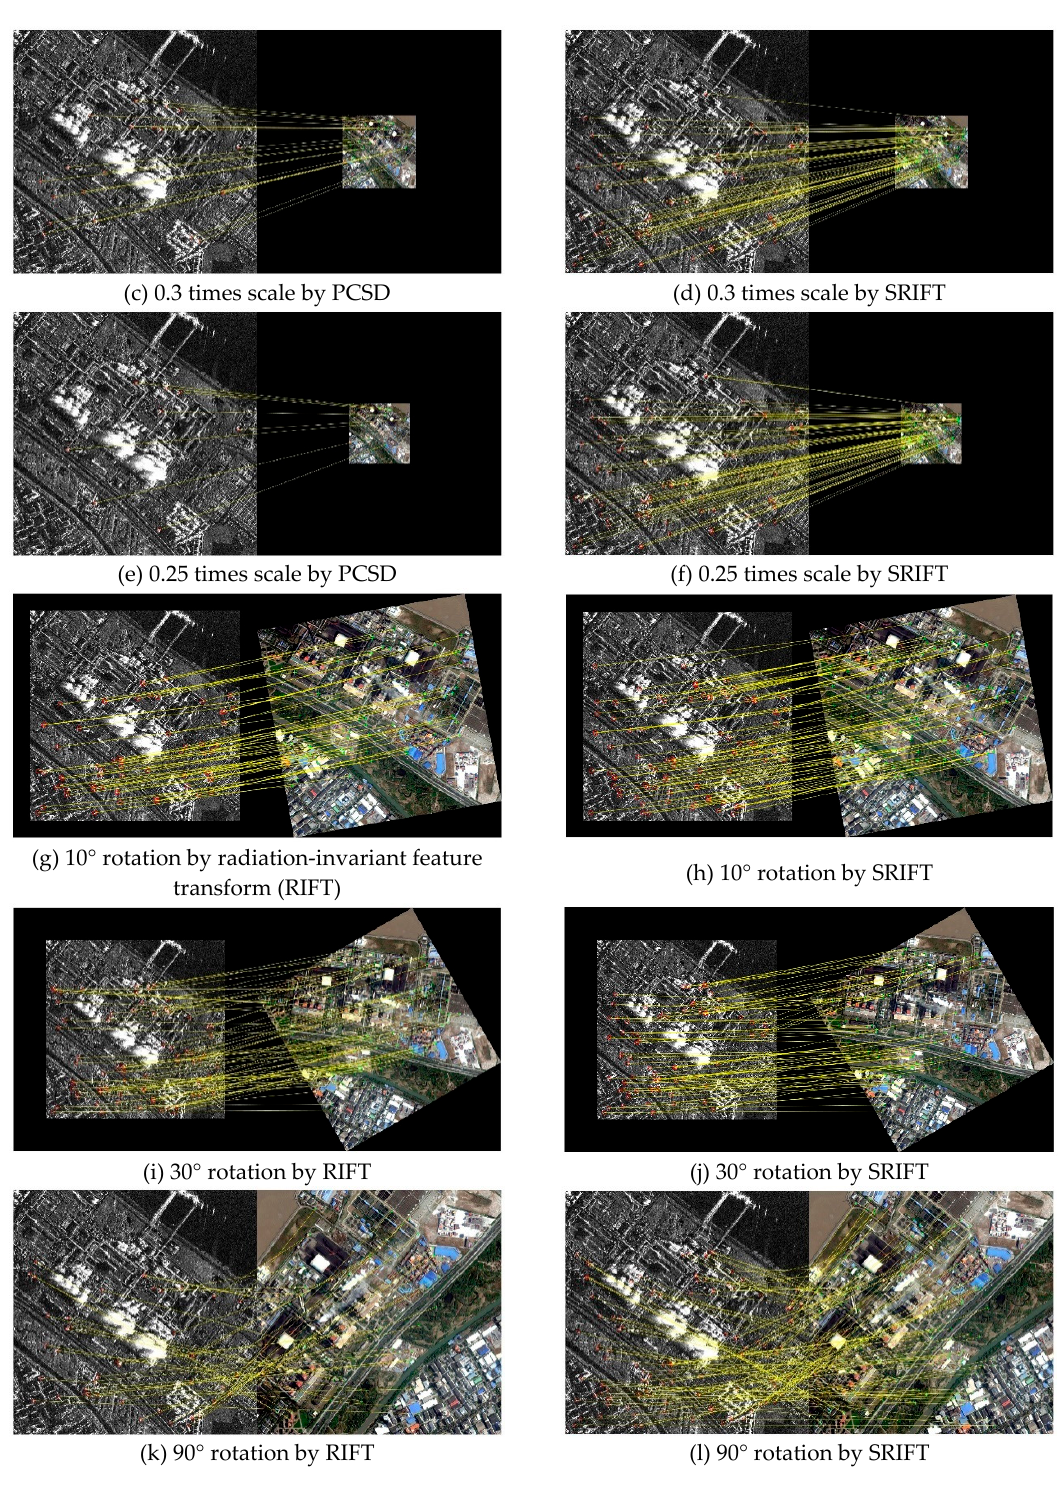
Figure 6. The simulated experiment results for the GF-3 and GF-2 images.